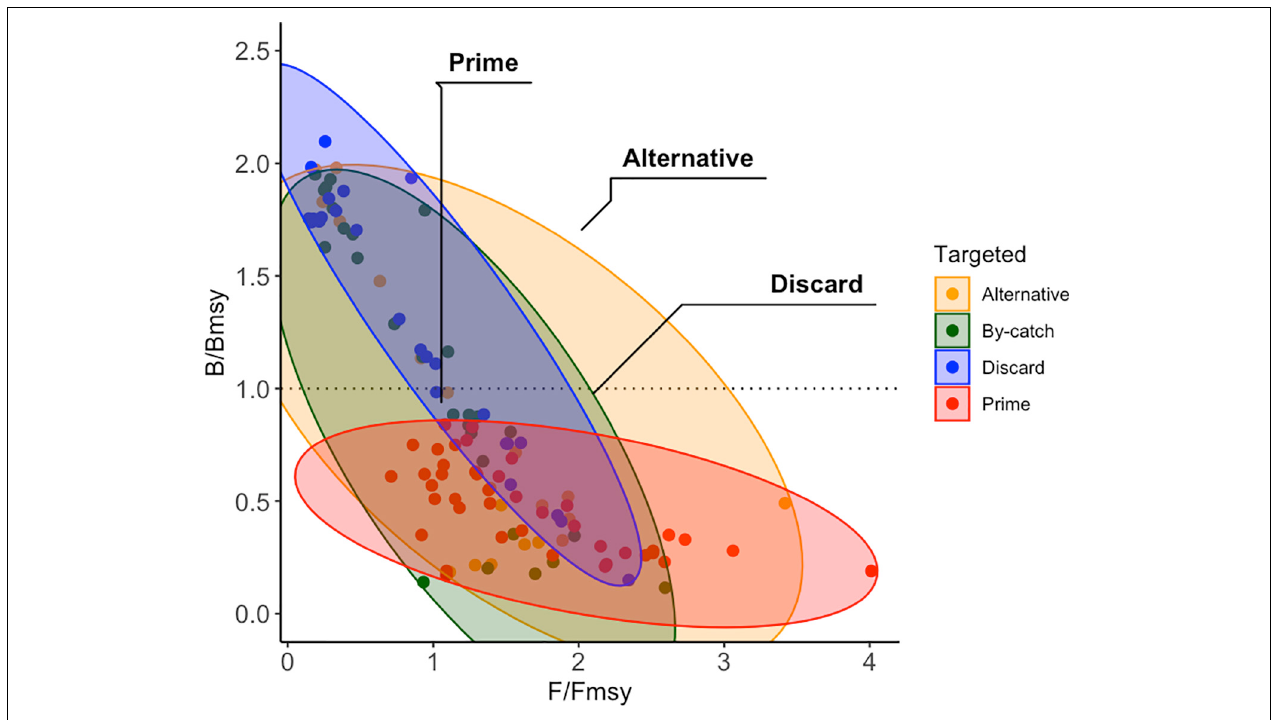
FIGURE 3 | Grouping of 116 fish and invertebrate stocks of the Aegean Sea (42 previously assessed stocks and 74 stocks assessed in the present study) based on their fishing pressure (F/F msy ) – stock status (B/B msy ) plot. Enclosing ellipses were estimated using the Khachiyan algorithm and expanded to cover all relevant points. Red dots and ellipse indicate prime targets ( n = 42), orange dots and ellipse indicate alternative targets ( n = 20), green dots and ellipse indicate by-catch species ( n = 28) and blue dots and ellipse indicate discarded stocks ( n =